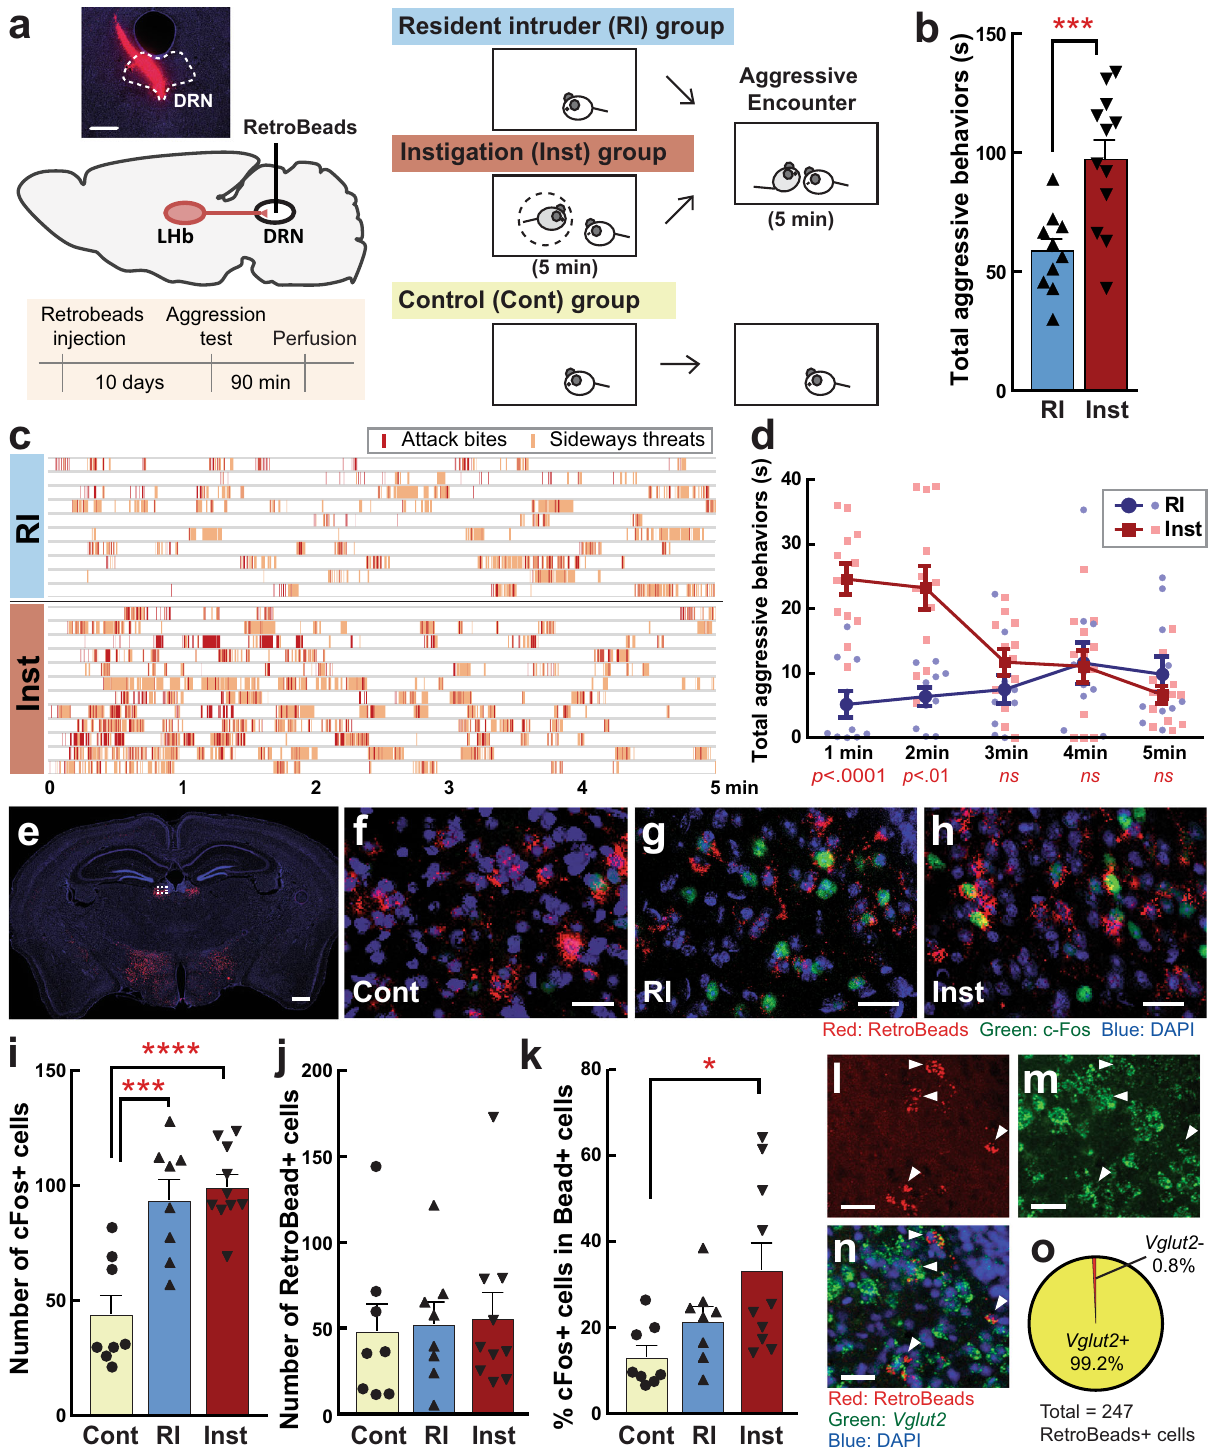
EGFP (referred below as hM4D), or Cre-dependent AAV2-EF1 α - DIO-ChR2(H134R)-EYFP (referred below as EYFP) as a control, into bilateral LHb (Fig. 3a). Speci fi c localization of GFP + neurons was observed in the LHb (Fig. 3b, c). Three weeks after AAV injection, we tested animals in the RI test and Inst test after i.p. injection of either saline (SAL) or 1 mg/kg clozapine-N-oxide (CNO; Fig. 3a). As expected, we found that social instigation increased the duration of total aggressive behaviors regardless of